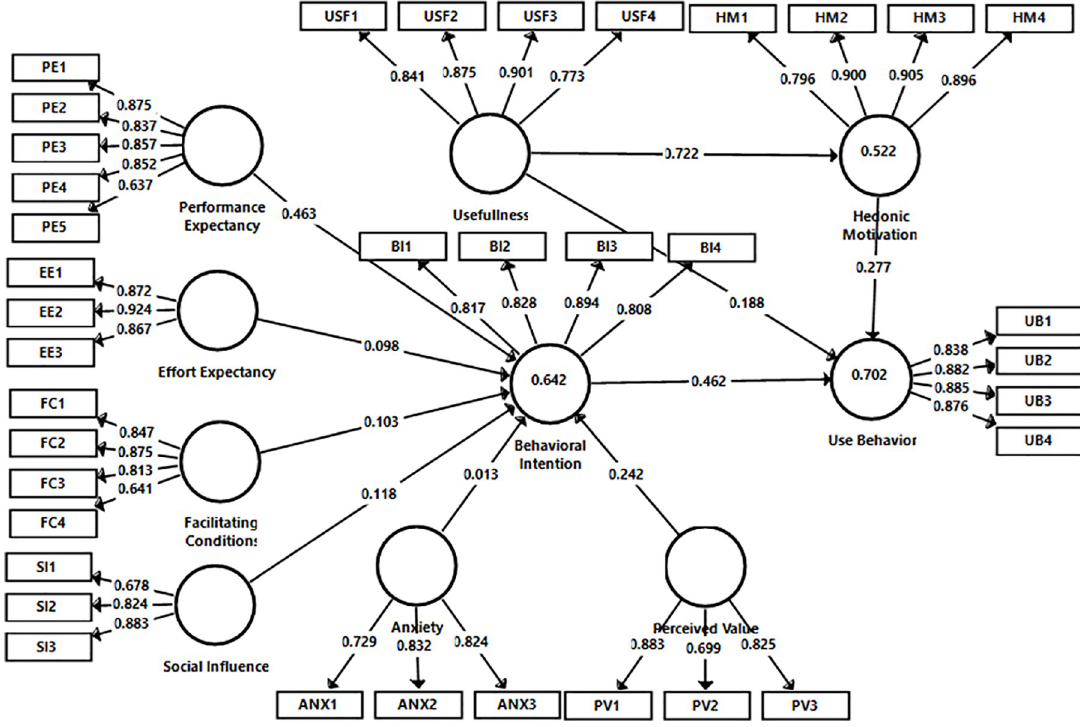
Fig 2. The research model path